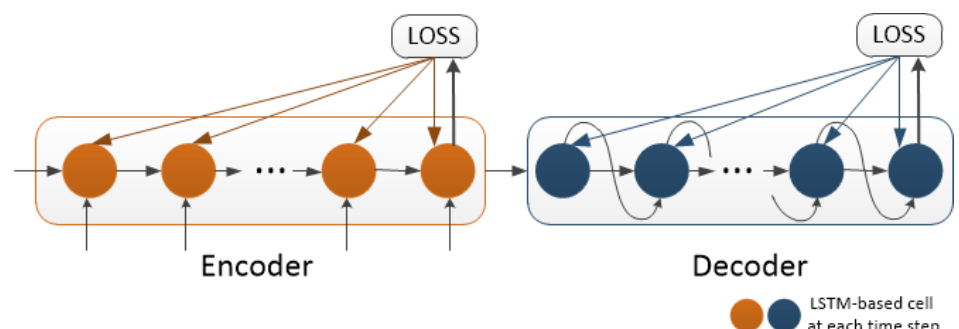
Figure 7. Model training using truncated back propagation through time.